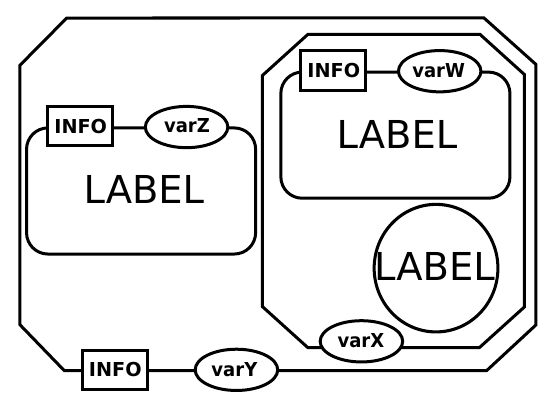
Figure 2.13: An example Process Description glyph for complex